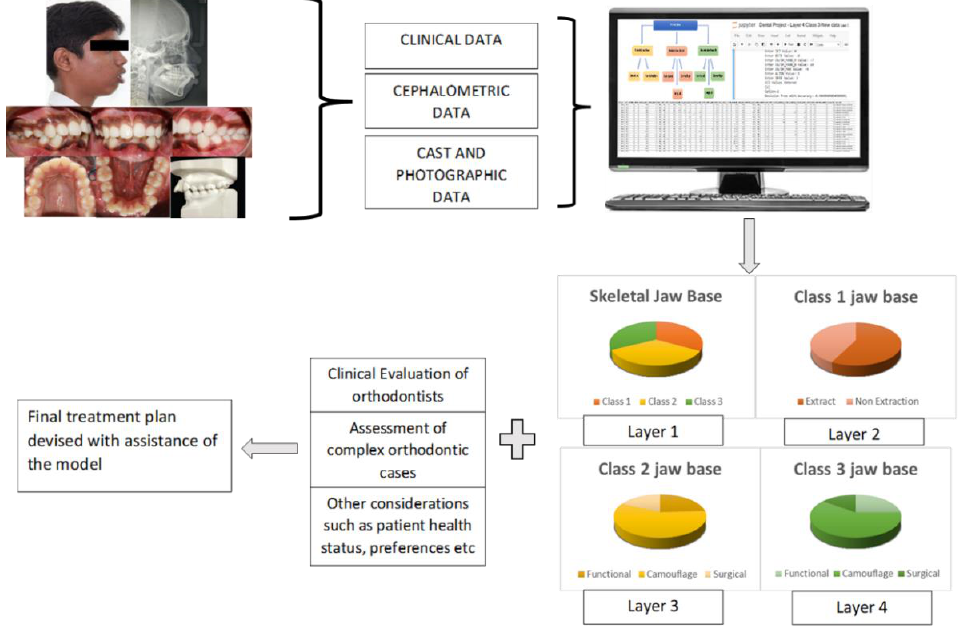
Figure 2. Illustration of computerized, quantified patient data and prediction of all layers. The Machine Learning model along with other considerations can aid in the formulation of the final treatment plan.